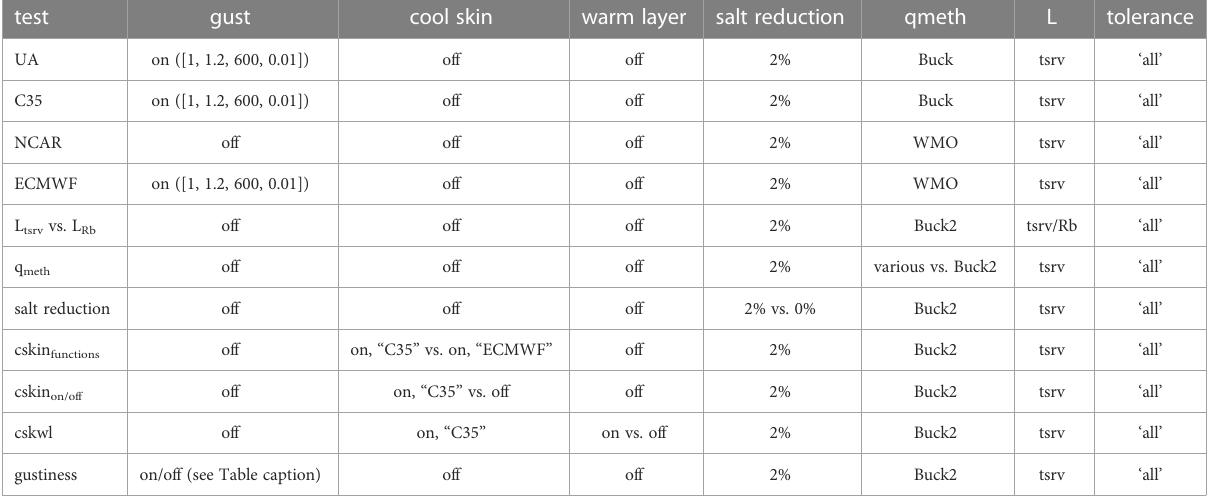
TABLE 9 A summary of the AirSeaFluxCode input options used in: Section 3.1 - the comparison against the original developer code where available ( fi rst four rows); Section 3.2 - test of different formulations for various parameters or optional adjustments (last 7 rows).